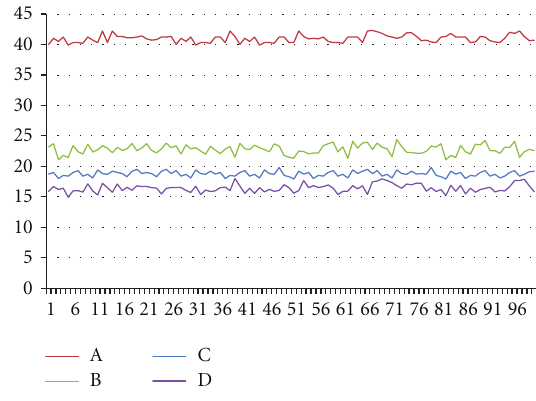
Figure 5: Results of various visualization tests: (A) wire frame mode in VRMMS (40.9 fps), (B) ball and stick mode in VRMMS (22.8fps), (C) wire frame mode in Co-Coot (18.8fps), and (D) surface mode in VRMMS